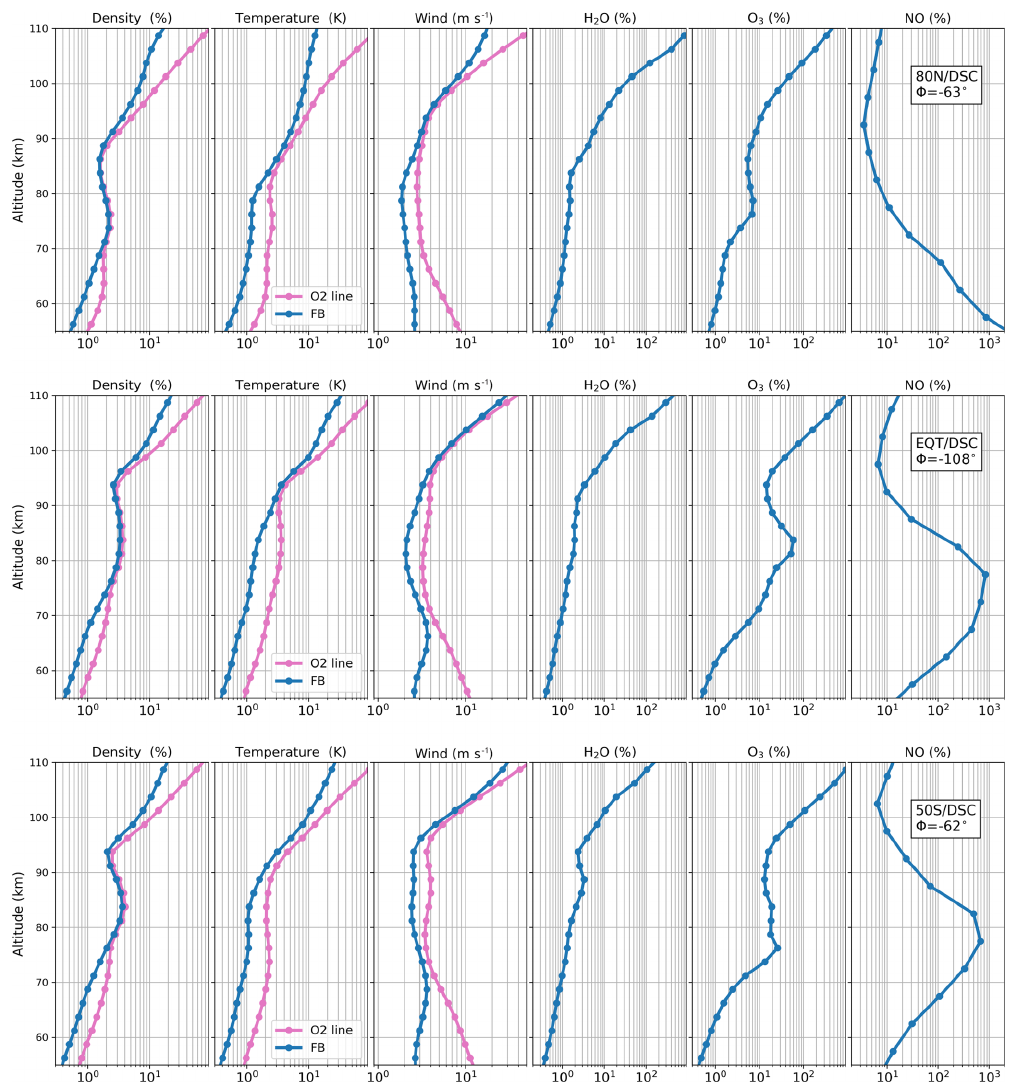
Figure 8. Errors on atmospheric density, temperature, LOS wind, H 2 O, O 3 and NO profiles. Only errors induced by the measurement noise are shown, for profiles retrieved from the antenna-1 signal using a radiometer with linear vertical polarization. The pink and blue curves show the results for the 200MHz narrow band around the O 2 line and for the full bandwidth, respectively. (a) Results at 80 ◦ N (polar night). (b, c) Results for daytime conditions at the Equator (b) and 50 ◦ S (c) . The vertical resolution for the retrievals is set to 2.5km for all profiles, except for NO, for which 5km is